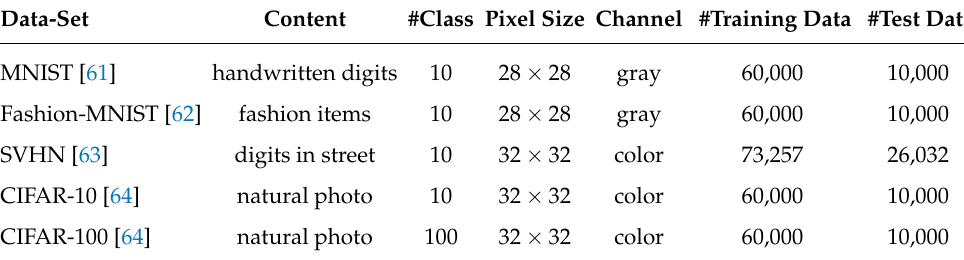
Table 1. Data-sets on the image classification used in our experiments.